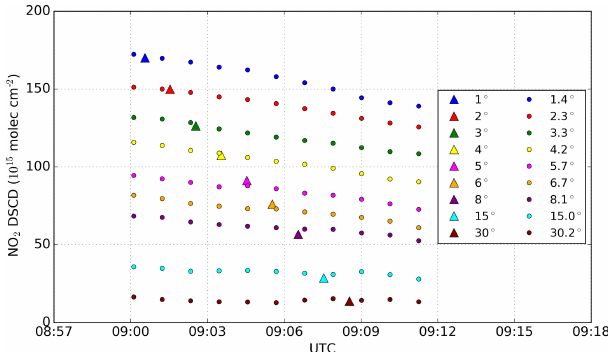
Figure 6. NO 2 DSCDs from an exemplary MAX-DOAS vertical scan (triangles) on 23 September 2016 compared to IMPACT (cir- cles). For these intercomparison measurements, both instruments were pointing in the same fixed azimuth direction of 287 ◦ (from north) as explained in Sect. 2.4 (bullet point 1). While different prescribed elevation angles were applied consecutively by MAX- DOAS, IMPACT measures the complete vertical scanning sequence simultaneously as a result of its imaging capabilities. However, note that IMPACT’s elevations deviate slightly from prescribed MAX- DOAS elevations.